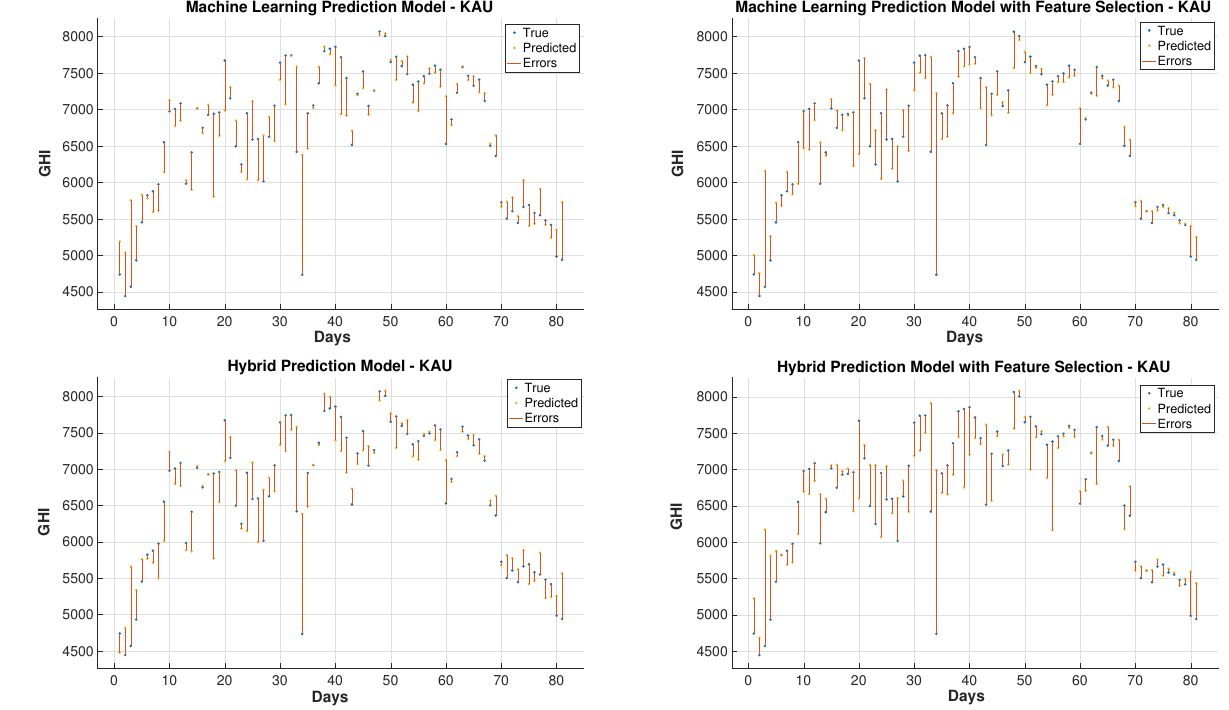
Figure 19. Prediction models for KAU with the dust storm dataset.